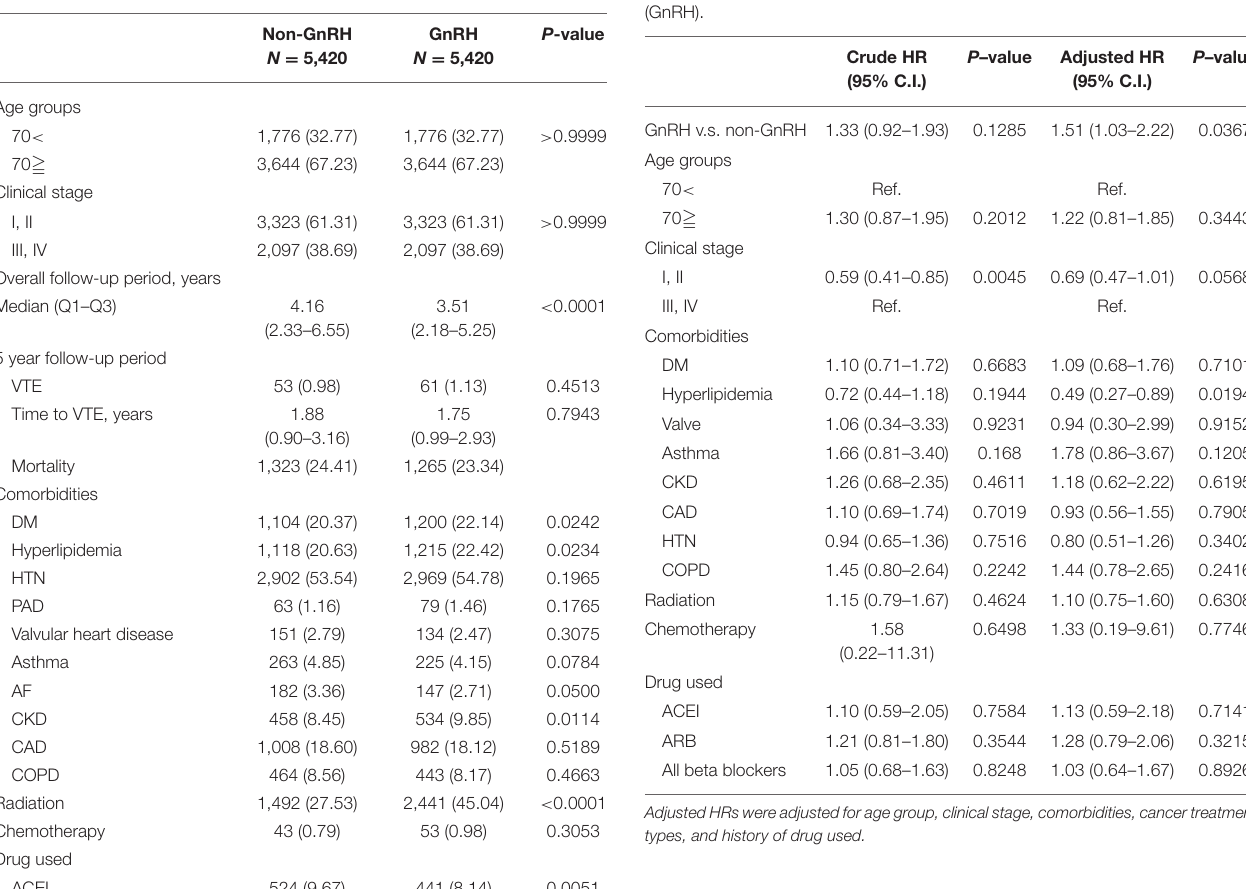
TABLE 1 | Demographic information of prostate cancer patient treated with gonadotropin-releasing hormone therapy (GnRH) or not after matching.